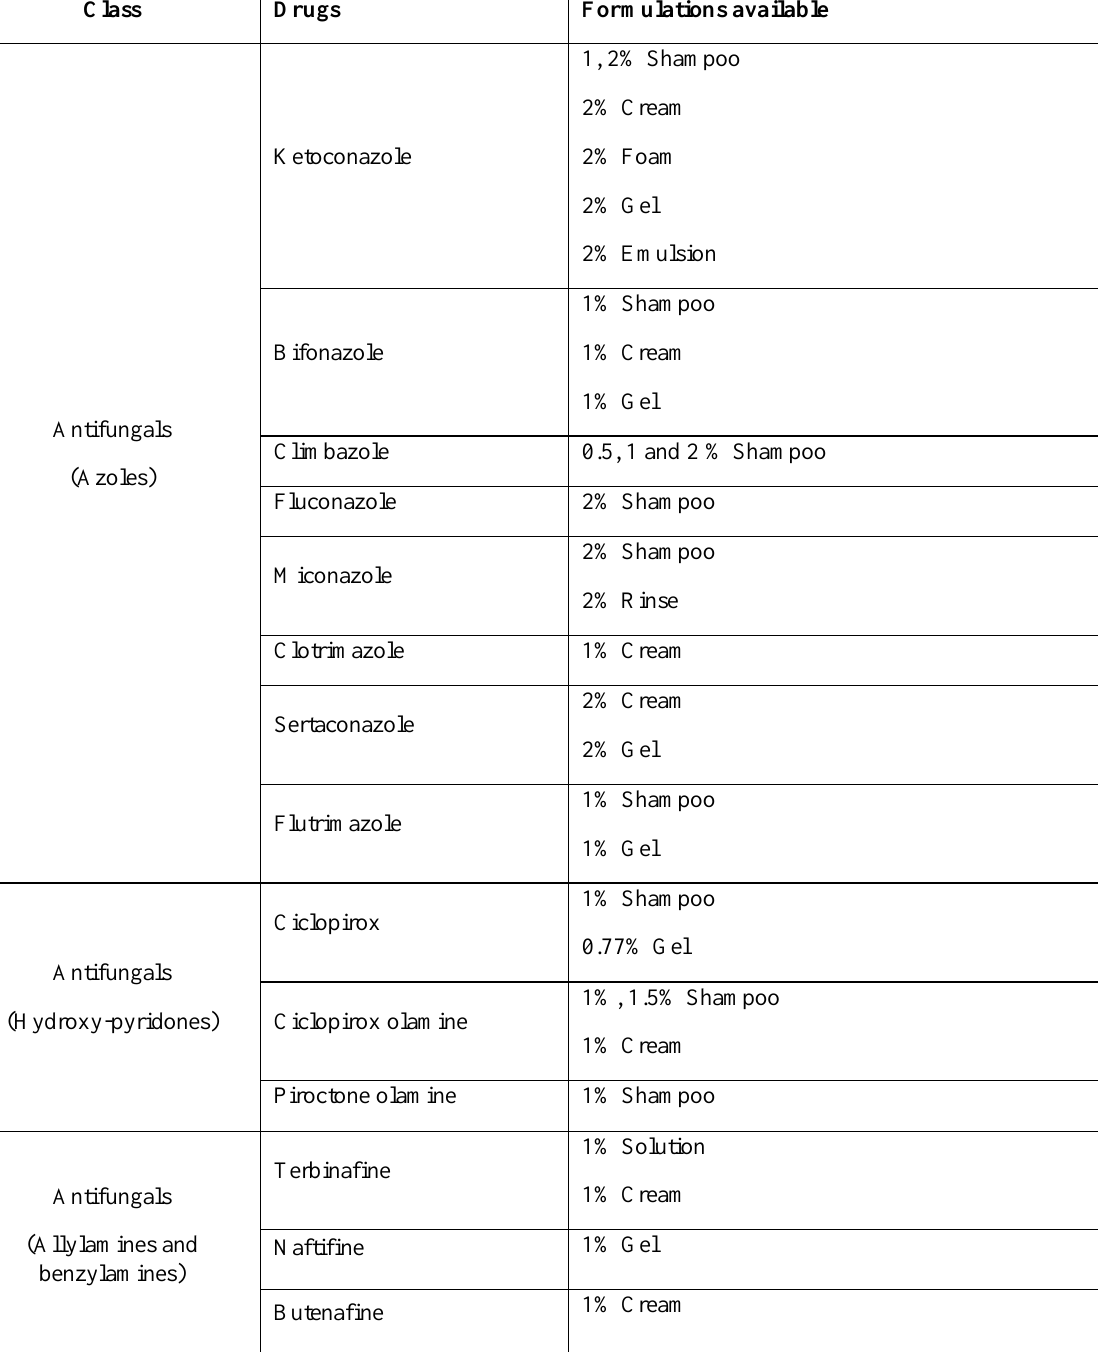
Table 1.Topical therapeutic agents used clinically for treatment of dandruff/SD * Class Formulations